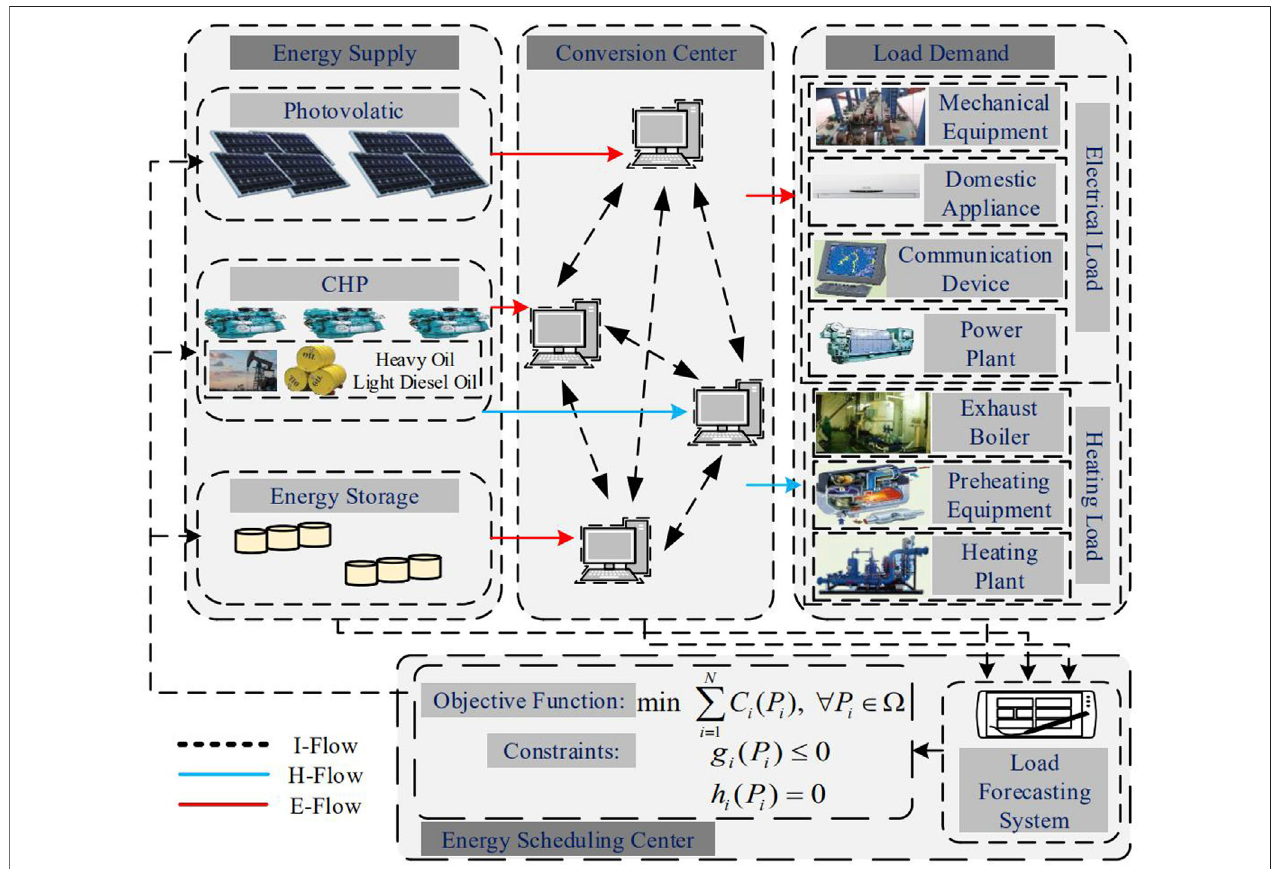
FIGURE 1 | Basic structure of the integrated energy system on intelligent